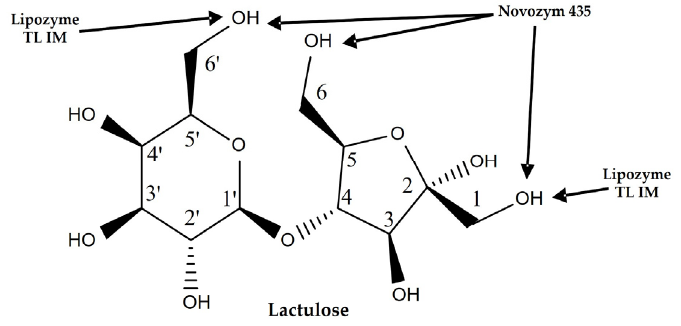
Figure 10. Lactulose acylation positions with Novozym 435 and Lipozyme TL IM.